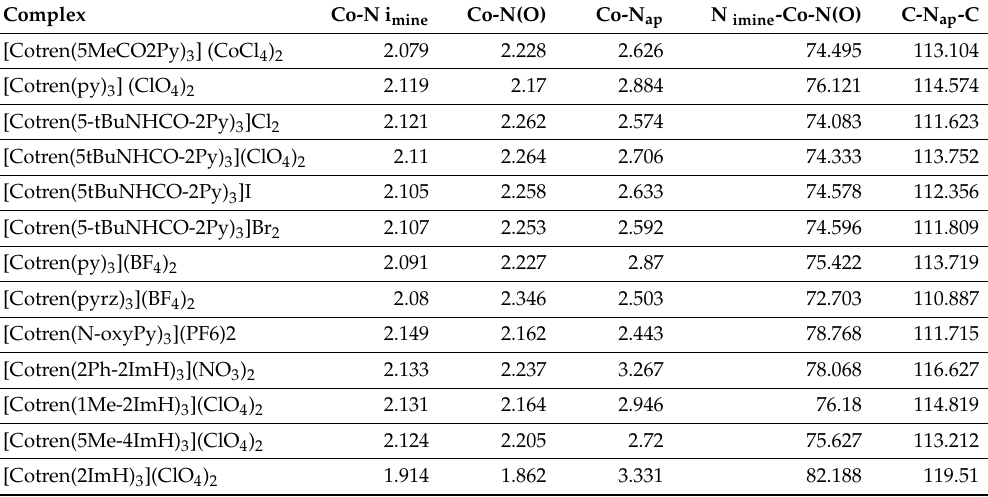
Table 5. Structural parameters of mononuclear cationic cobalt(II) complexes. Distances are in Å and angles in ◦